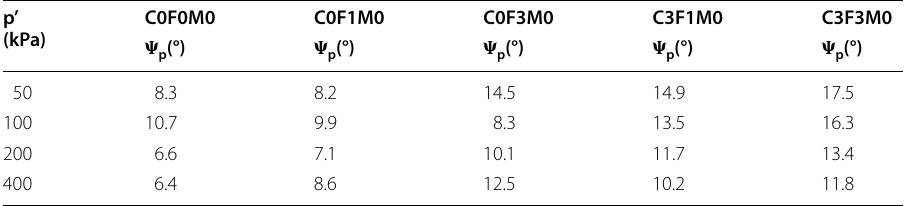
Table. 3 Peak dilatancy angles from the CID compression tests for unreinforced, fibre reinforced, and fibre reinforced cemented Toyoura sand specimens p’